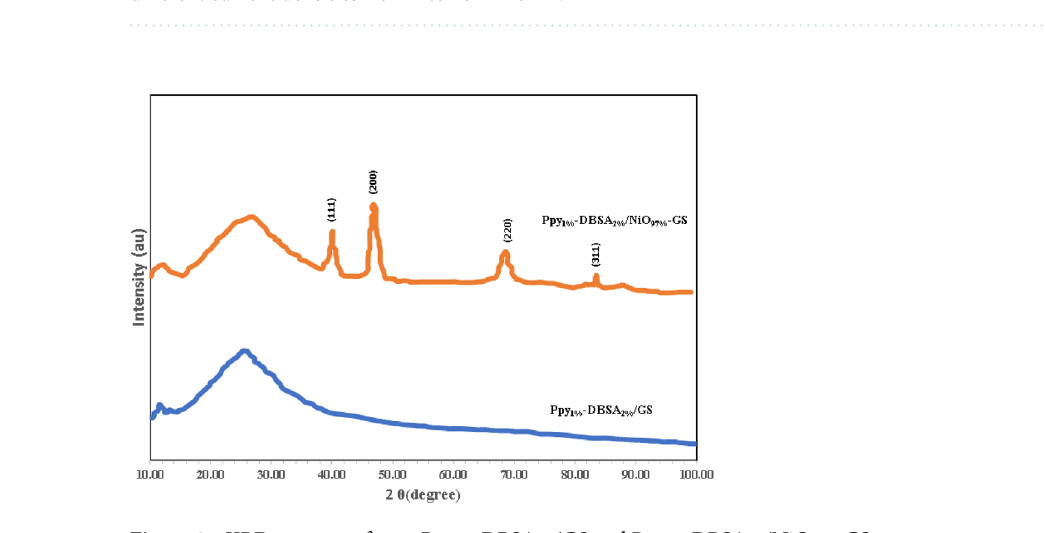
Figure 2. XRD patterns of pure Ppy 1% -DBSA 2% /GS and Ppy 1% -DBSA 2% /NiO 97%